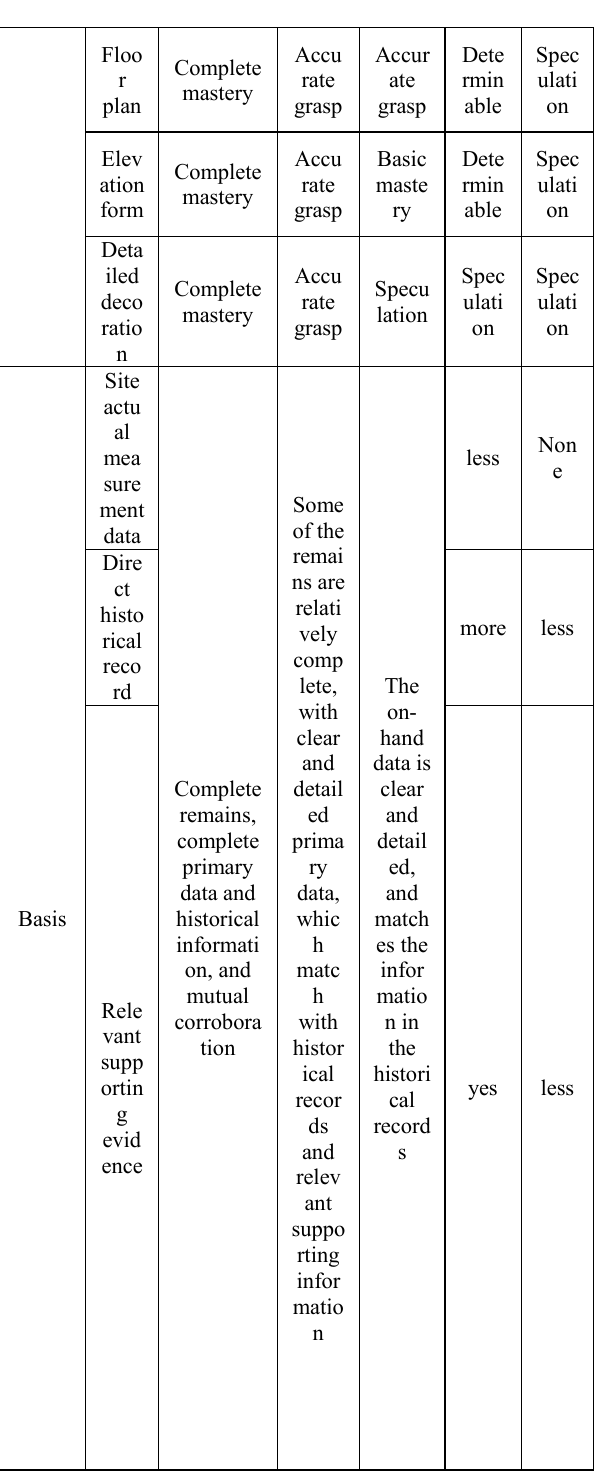
Table 2. Accuracy evaluation table